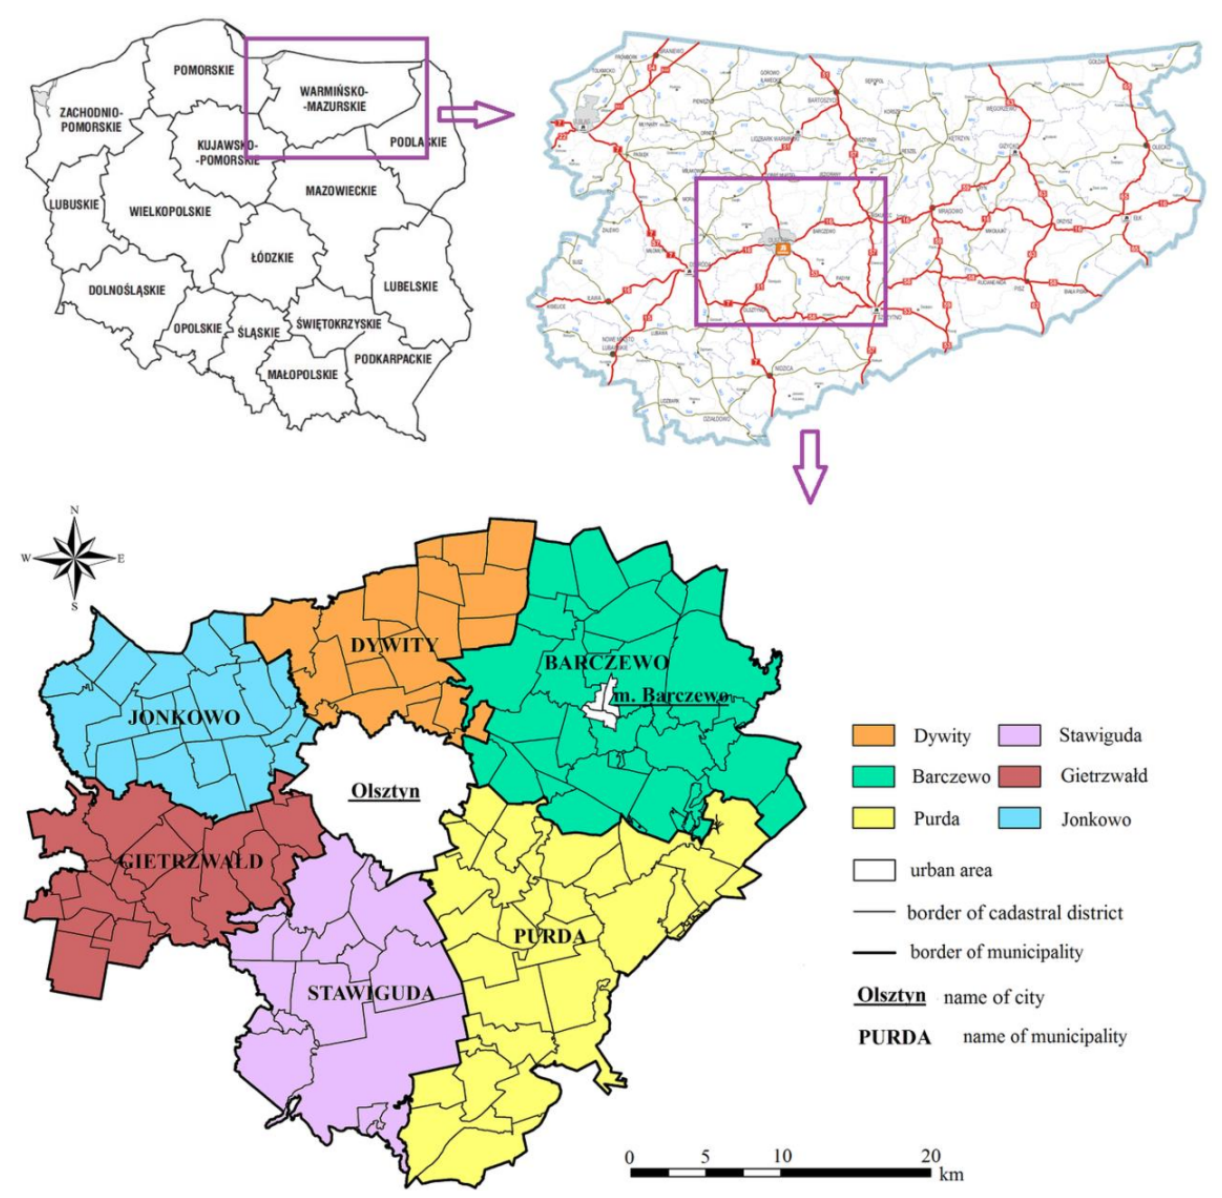
Figure 2. Study area. Source: own